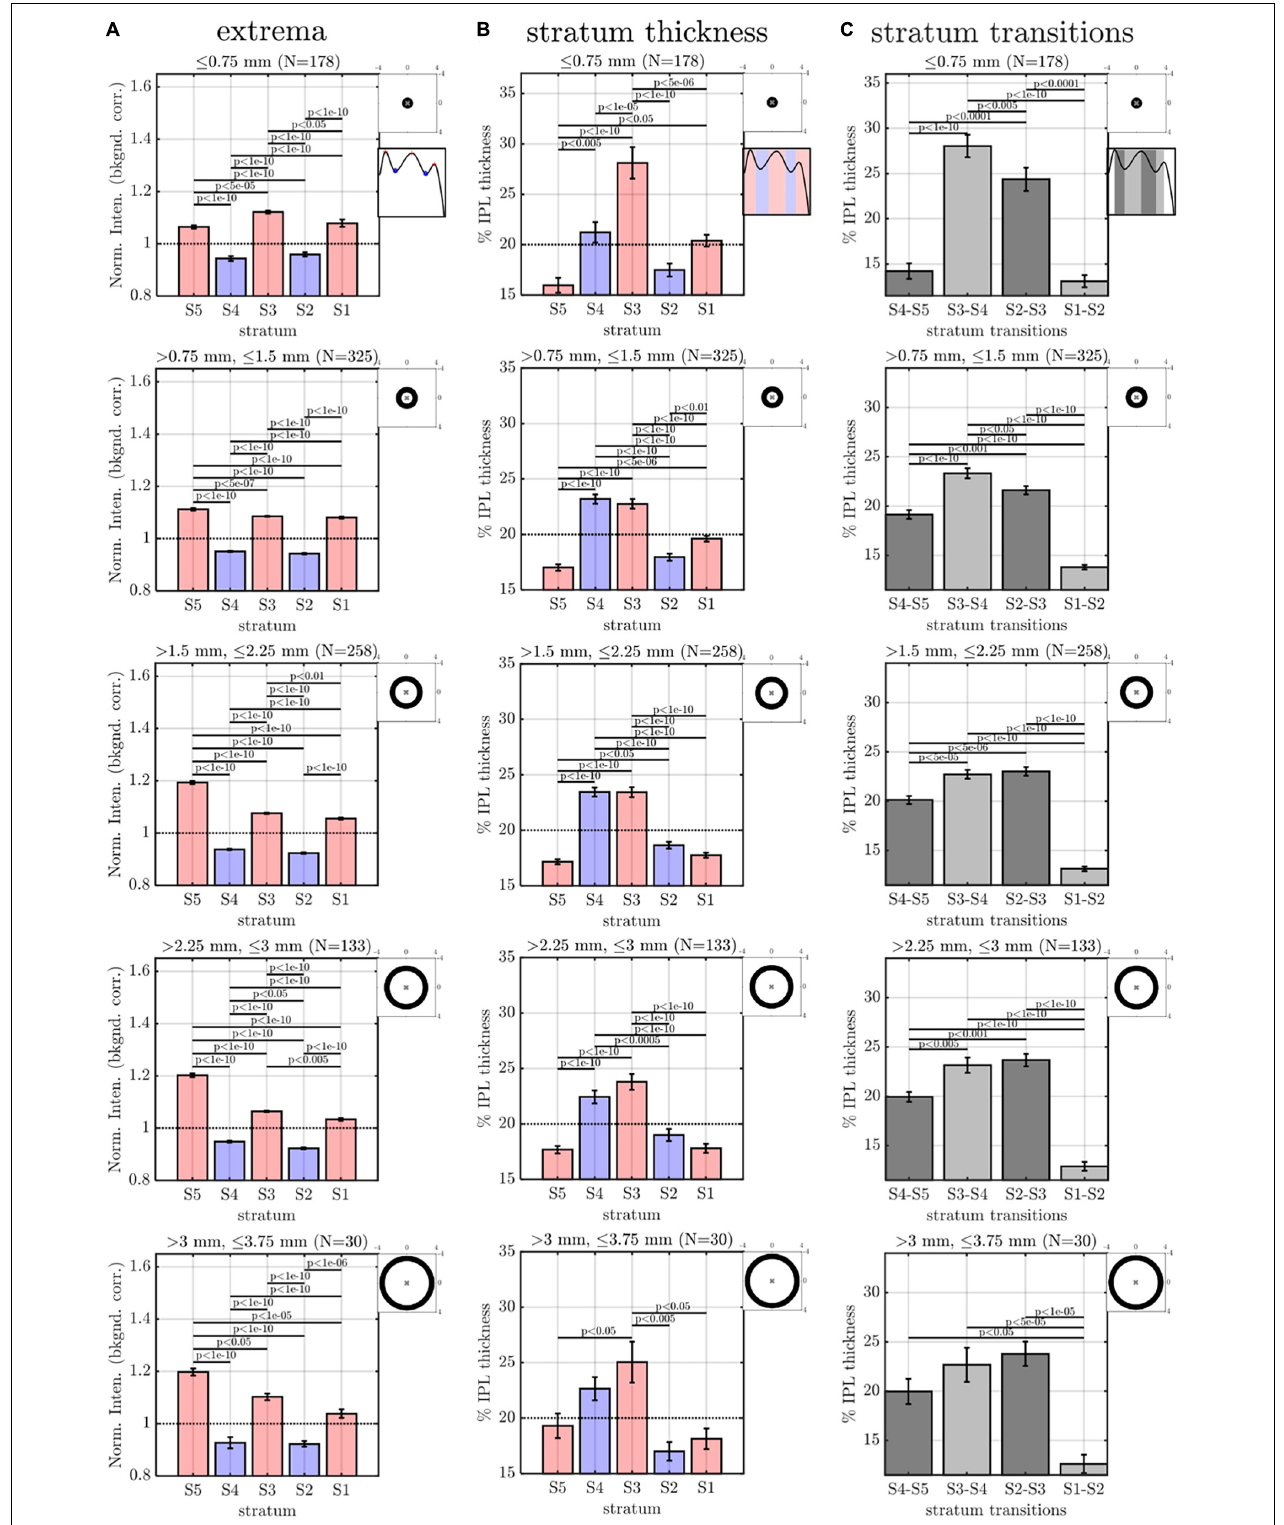
FIGURE 6 | Eccentricity-wise summary of segmental IPL parameters, derived from the averaging and fitting procedure shown in Figure 3 : extrema (A) , thicknesses (B) , and transitions between strata (C) . Note that since segmental profiles are not averaged before determining extrema, stratum contrast is increased relative to Figure 5 , though the trends remain consistent. Topographic images show annuli for eccentricity binning relative to the foveal center (“x”).